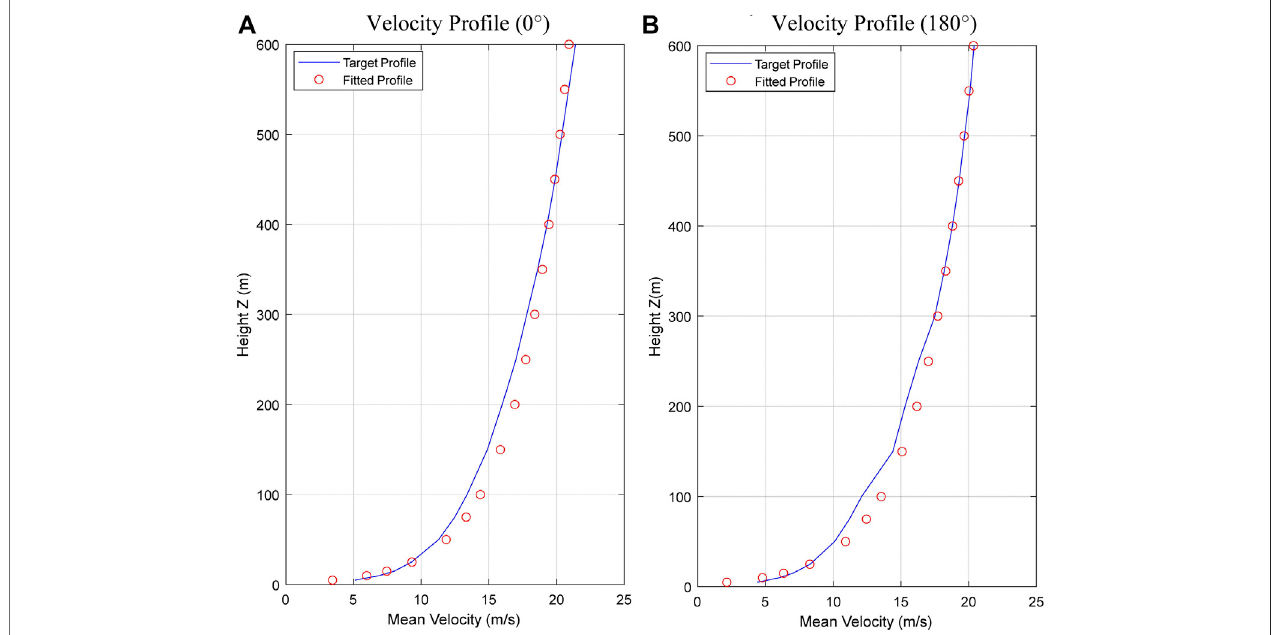
FIGURE 5 | Velocity pro fi les and fi tted logarithmic pro fi les (tile 50G_North2).